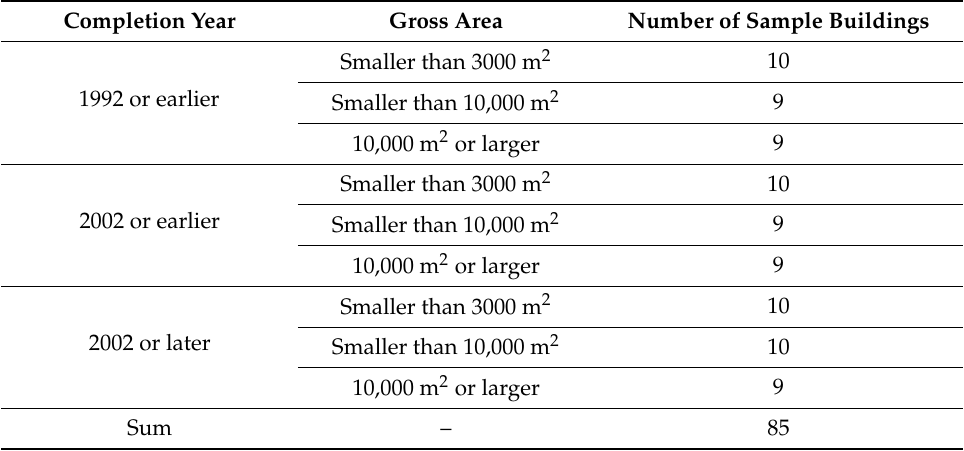
Table 1. Total sample design of o ffi ce